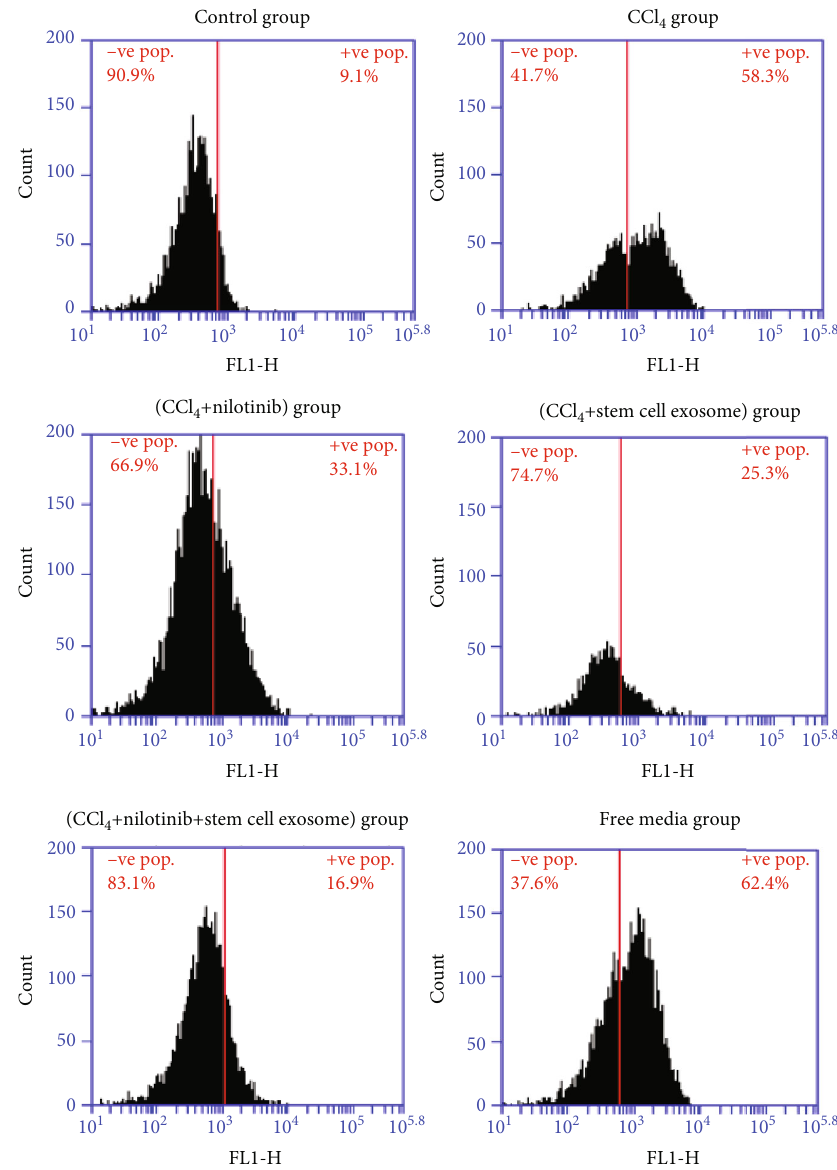
Figure 2: Caspase 3 apoptotic marker among the studied